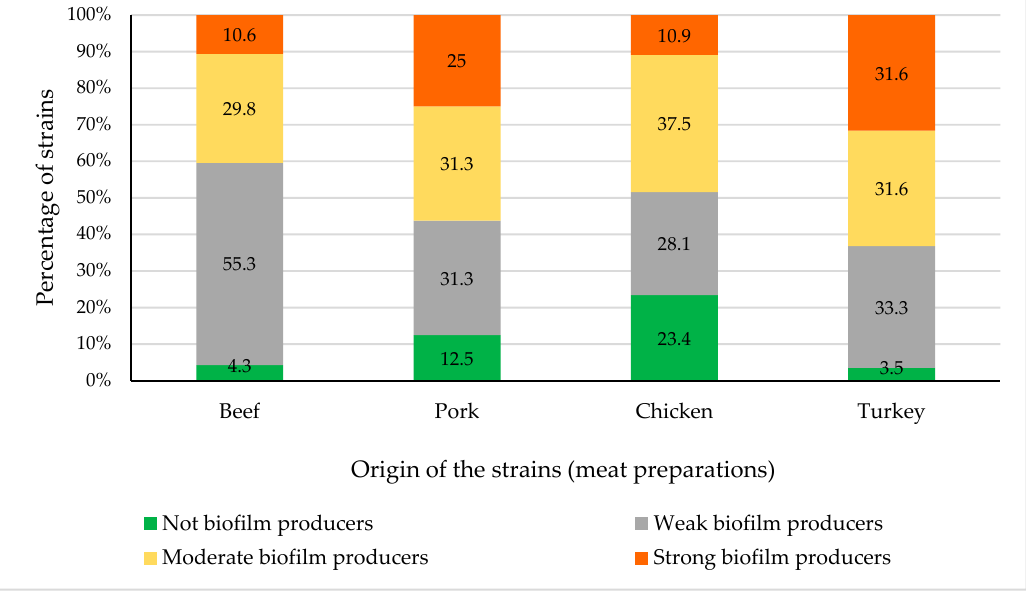
Figure 2. Percentage of not biofilm producer isolates and of weak, moderate, and strong biofilm producer isolates from beef, pork, chicken, and turkey preparations.